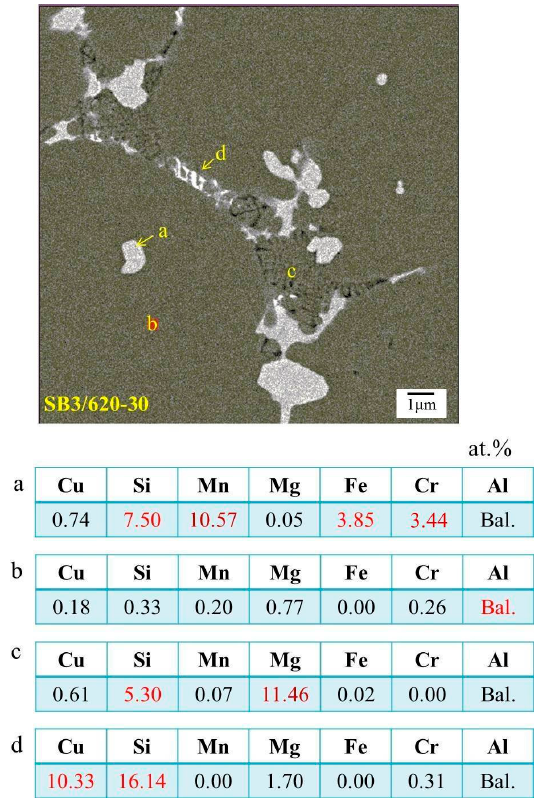
Figure 11. Phase analysis of SB. a: Al 15 (Fe,Mn,Cr) 3 Si 2 particle; b: Al matrix; c: dark grain boundary or liqud pool; d: bright grain boundary; red number: major element.